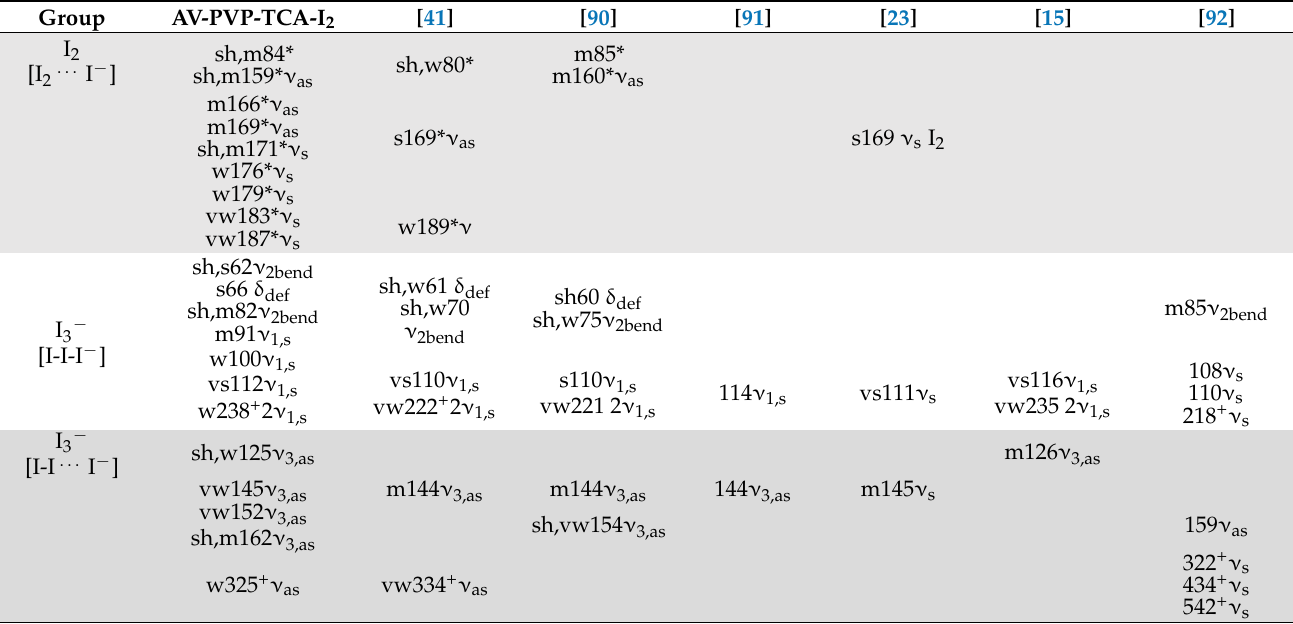
Table 1. Raman shifts in AV-PVP-TCA-I 2 (1) (cm − 1